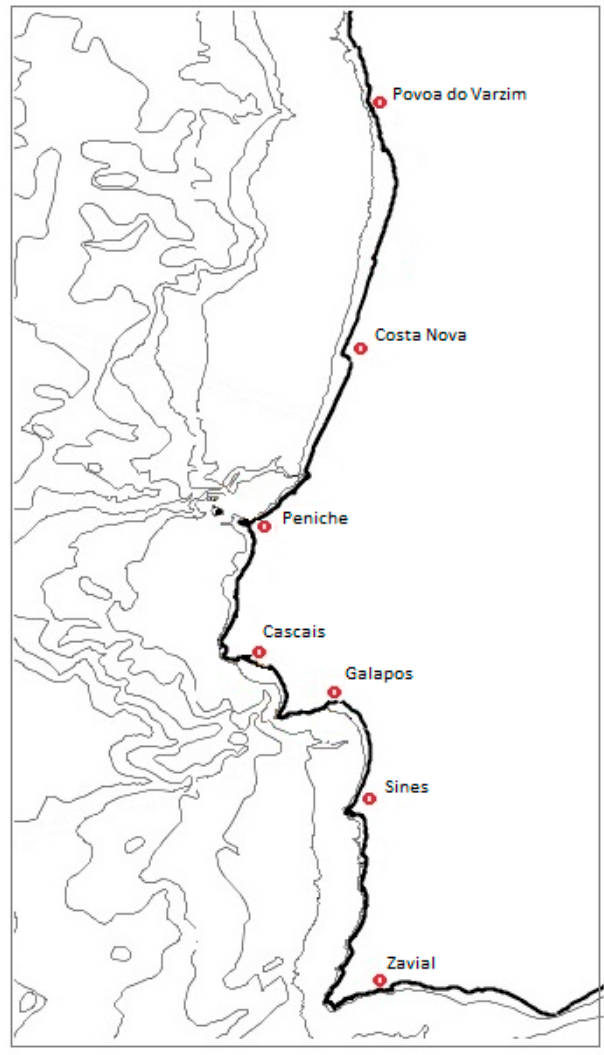
Figure 1. Fecundity sampling locations along the Portuguese coastline.